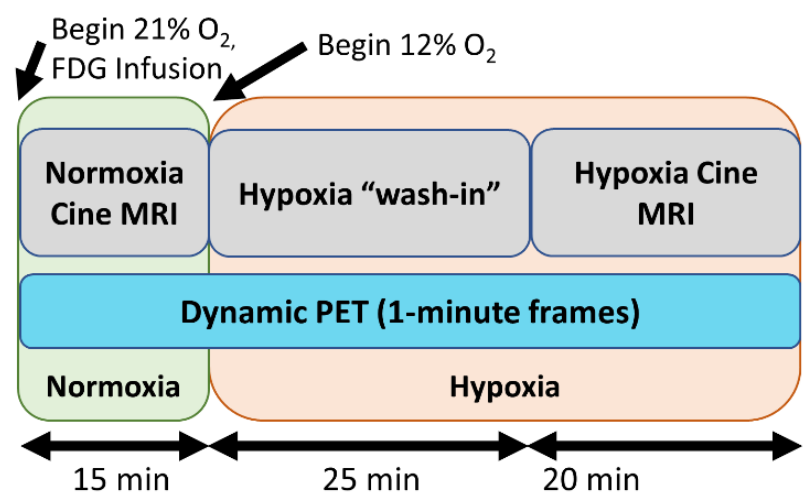
Figure 1. Imaging protocol: In the first 15 min, the subjects breathe 21% oxygen. Subsequently, the oxygen levels are reduced to 12% for 45 min. Cine MRI data are acaquired during the normoxia and, after a 25 min period of a hypoxia ‘washin’ phase, during hypoxia. (18)F-fluorodeoxyglucose (FDG) is continuously infused and dynamic PET data are continuously acquired throughout the imaging